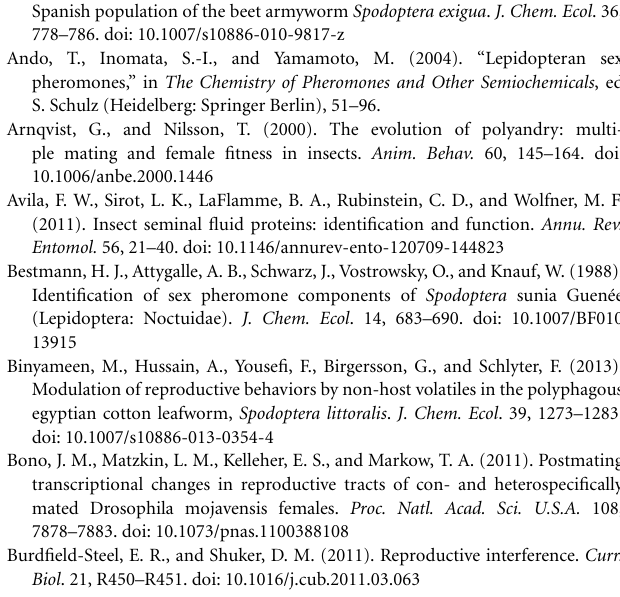
migration ( ∗∗ ). Bold arrows show steps toward compounds found in both species, S. littoralis and S. litura (rounded rectangles), red arrows show proposed pathways for newly identified compounds in S. littoralis (see Table 1